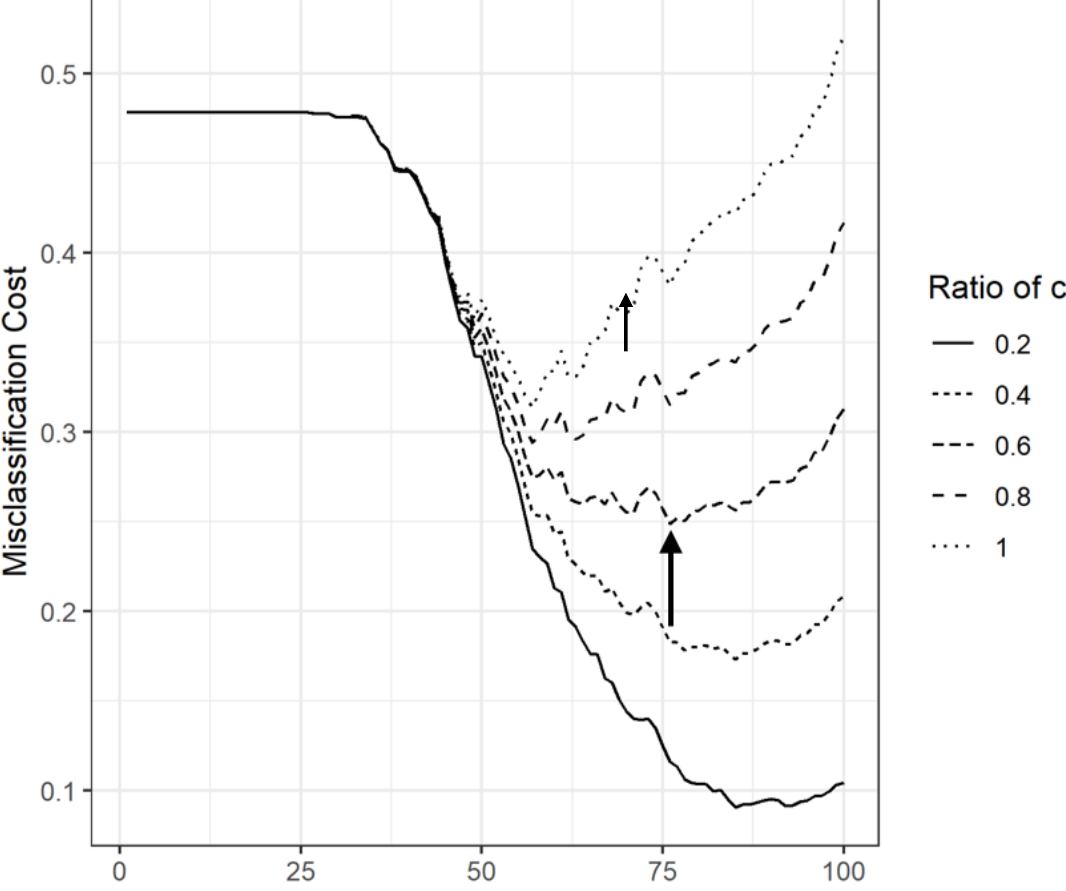
Figure 4. Misclassification cost term at day 60 of a nomogram predicting survival of dairy cows coming from 124 herds in Québec, Canada with severe clinical mastitis in the 60-day period following after first veterinary evaluation (FN: False negative; FP: False Positive). The arrow indicates the minimal cost for a ratio of 0.6, the minimal cost is the economically optimal cut-off point of this ratio.